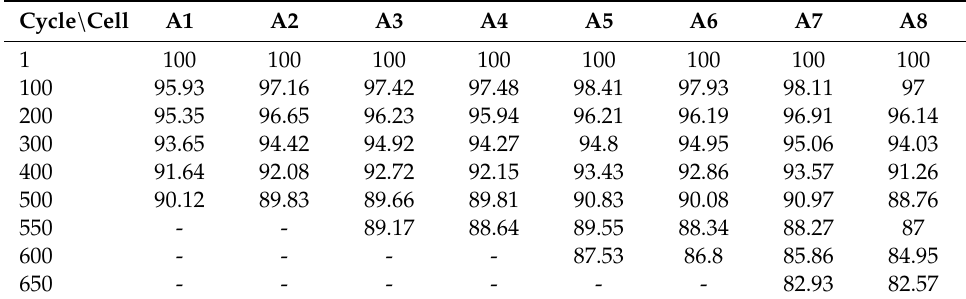
Table 2. The state-of-health (SoH) obtained from the electrochemistry-based electrical (ECBE) model for each cycle and